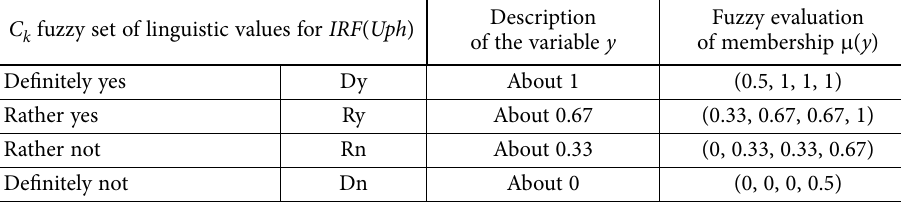
Table 5. Fuzzy interpretation of the linguistic output variable y – IRF(Uph) C k fuzzy set of linguistic values for IRF ( Uph